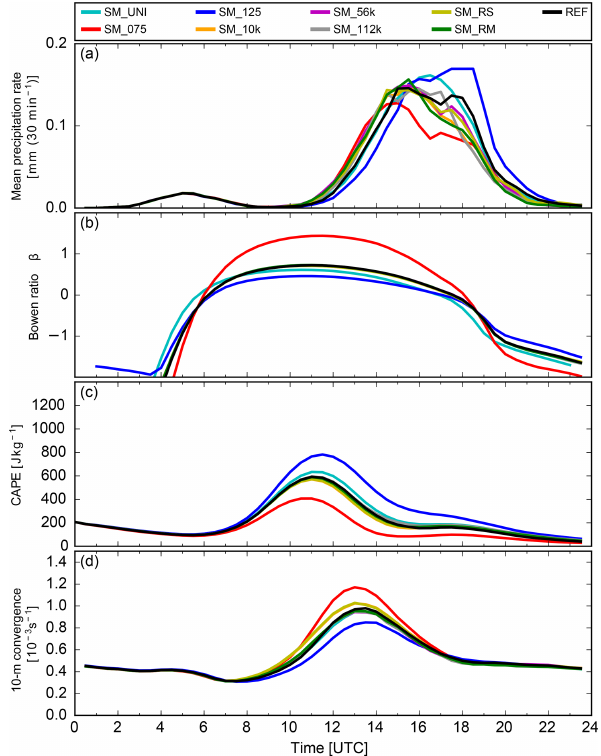
Figure 10. Temporal evolution of mean precipitation rate, Bowen ratio, CAPE, and 10m wind convergence on 23 July 2013 in the soil moisture sensitivity